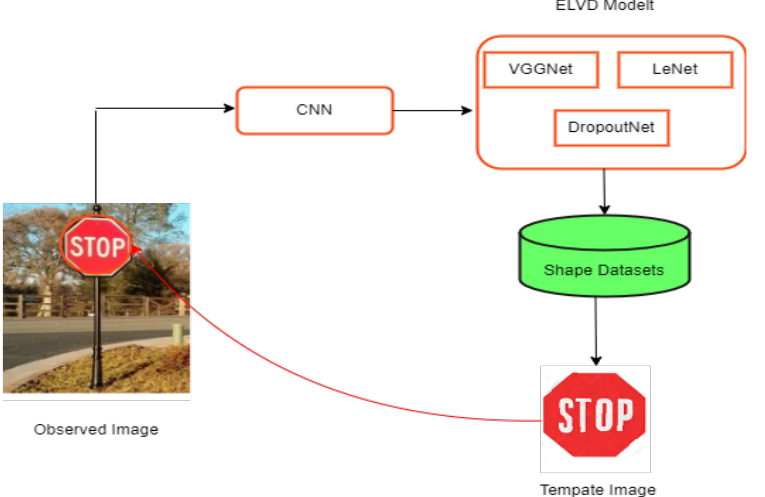
Figure 12. Working procedure ELVD Architecture . For each parameter, the Adam algorithm calculates adaptive learning rates. In addi- tion to storing the average of the previous squared gradients with exponential distribu- tion, for each parameter, the Adam algorithm calculates adaptive learning rates. The av- erage of the consecutive squared gradients with an exponential distribution is further re- tained.